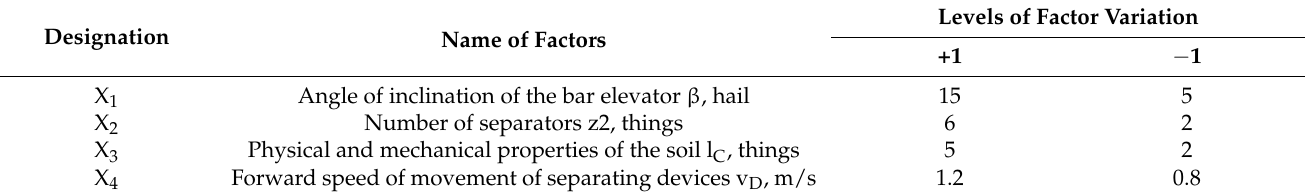
Table 2. Factors affecting the quality of potato harvesting.